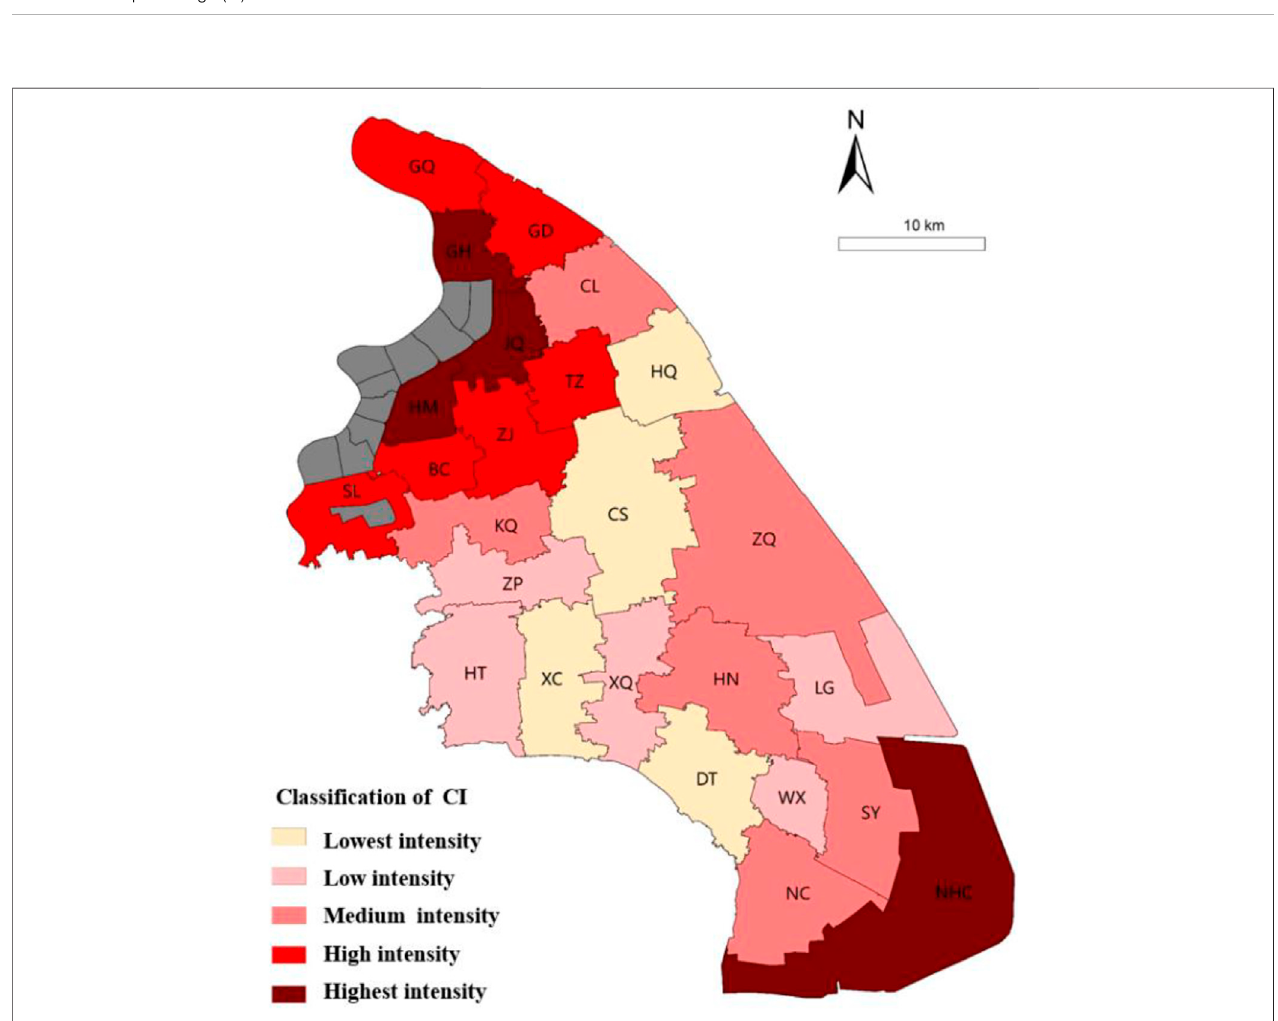
FIGURE 4 | CI of rural settlements at the township level in Pudong from 2000 to 2018.